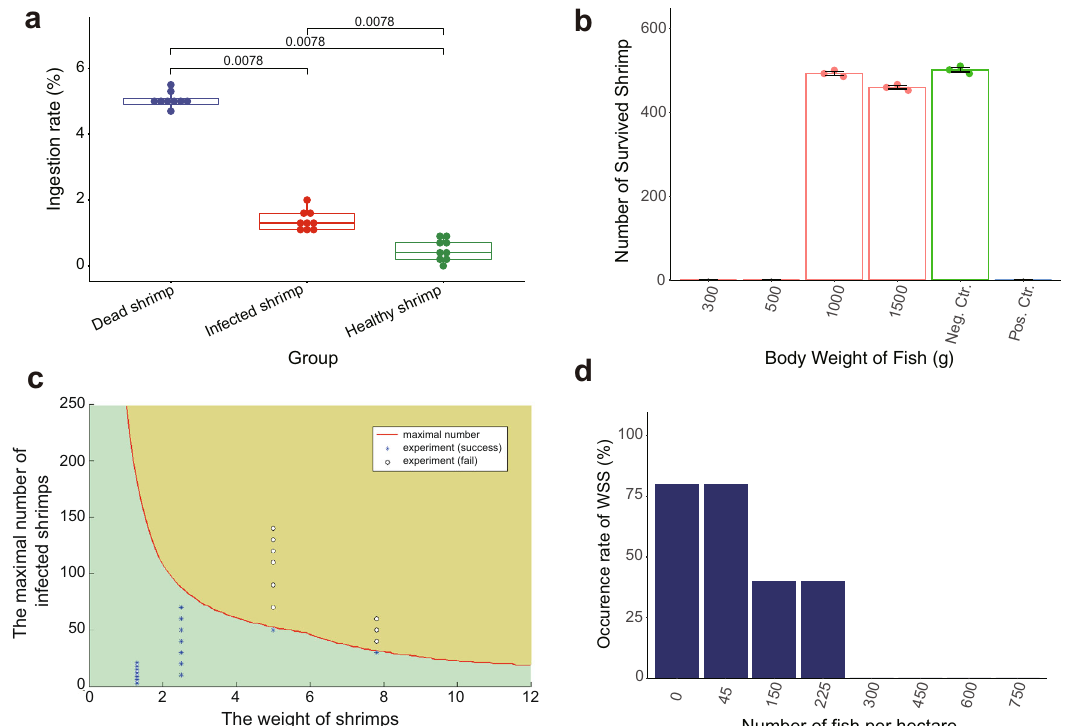
Fig. 2 Speci fi cation of grass carp for the control of WSSV transmission. a Feeding selectivity of grass carp on dead, infected (endopod and exopod removed), and healthy shrimp. The diseased shrimp infected with WSSV died within two days, which makes it hard to distinguish the initial dead shrimp from the ones that were died from diseased shrimp. The diseased shrimp had reduced activity, and the activity of shrimp was reduced after the endopods and exopods were removed. Thus, the shrimp with endopods and exopods removed were utilized to resemble WSSV-infected shrimp. P -values (permutation test, paired) were labeled ( n = 9). Grass carp ingested signi fi cantly more dead shrimp than infected (endopod and exopod removed) and healthy shrimp. b The effect of the different body weights of grass carp on the control of WSS outbreaks. Means and standard errors are shown ( n = 3). c Capacity of 1-kg grass carp to control WSS. Blue asterisks represent the number of infected shrimp successfully controlled by one 1-kg grass carp, while clear circles represent the number of infected shrimp that failed to be controlled by one 1-kg grass carp. The red line is the simulated highest value of one 1-kg fi sh that can control the number of infected shrimp with different body weights based on model 3. d The relationship of the number of cocultured grass carp and the occurrence rate of WSS. More than 300 grass carp of approximately 1.0 kg per hectare can completely control WSS outbreaks, but fewer than 225 grass carp cannot fully control WSS